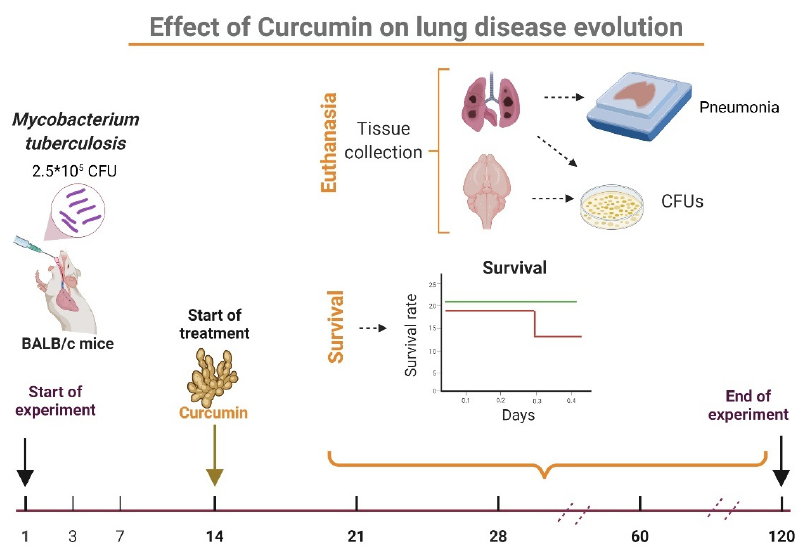
Figure 10. Experimental design to evaluate curcumin (CUR) therapy on the progression of lung disease. Eight-week-old BALB/c mice were infected with 2.5 × 10 5 live and viable Mtb H37Rv. The therapy with CUR began on day 14. We administered two CUR doses: 16 or 32 μ g/mL, and a group was treated with a saline solution (SS) as control. Post-infection animals were euthanized on days 21, 28, 60, and 120, and the brain and lungs were taken to assess the bacillary burdens and pneumonia area. In addition, we assessed the animal’s survival during the whole experiment. Each experimental age group’s samples were examined individually (created with BioRender.com, accessed on 27 June 2021).